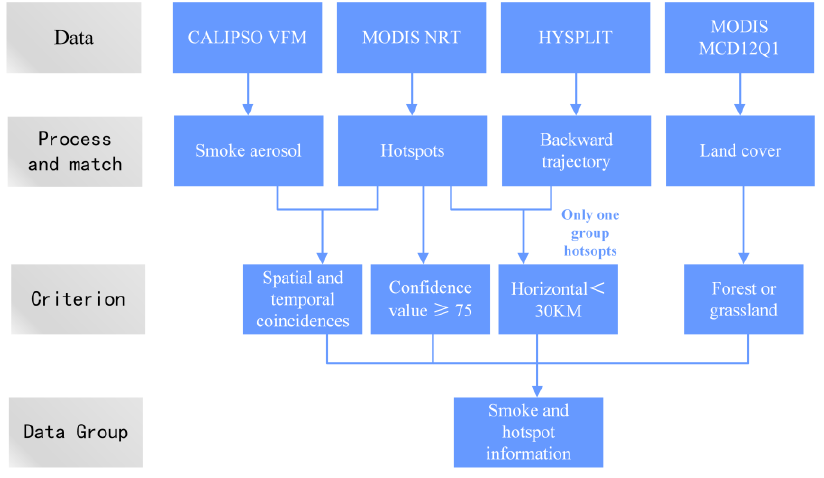
Figure 3. Method of establishing the SIH data groups.